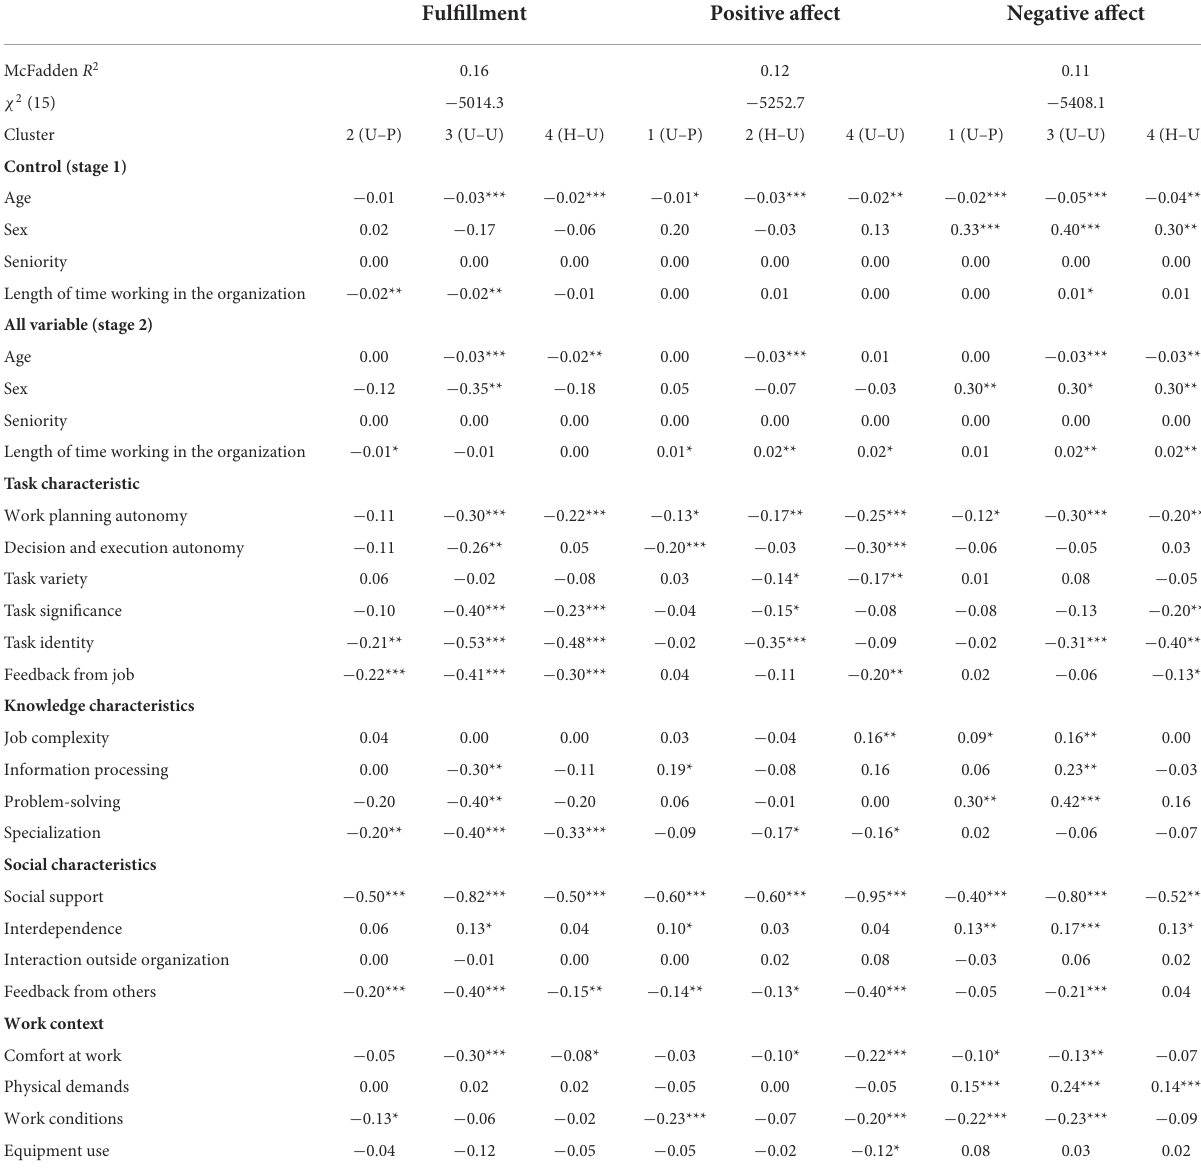
TABLE 1 Multinominal logistic regression analysis between work characteristics and clusters of wellbeing and performance. Fulfillment Positive affect Negative affect McFadden R